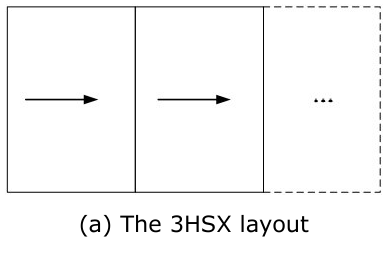
Figure 5. The types of the 3HS